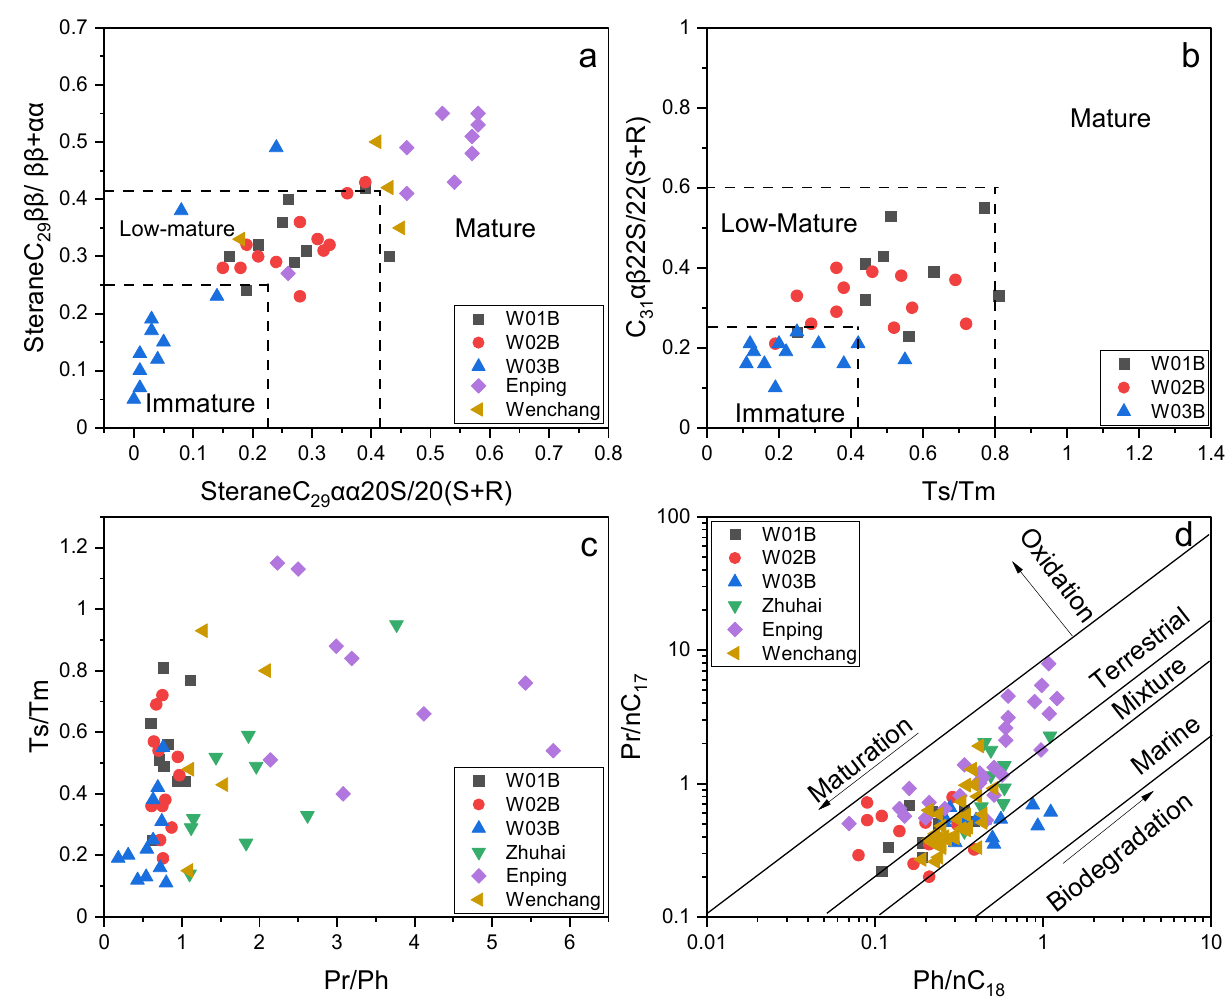
Figure 8. Maturity parameters of sterane ( a ) and hopane ( b ) in the sediment of W01B, W02B, and W03B. Plot of C 29 ββ /( ββ + αα ) vs. C 29 20S/(20S + 20R) showing the thermal maturation level of the